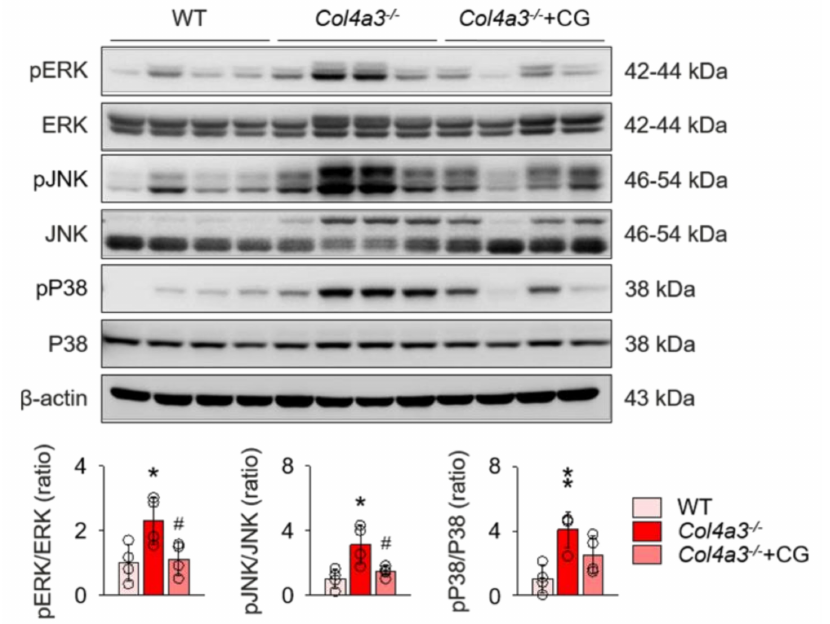
Figure 5. Enhanced phosphorylation of ERK and JNK in Col4a3 − / − mice was suppressed by CG. Comparison of protein expression level of mitogen-activated protein kinases (MAPKs) determined by immunoblotting from the kidney of WT, Col4a3 − / − , and Col4a3 − / − + CG mice ( n = 4 mice / group). β -actin was used as the endogenous control. * p < 0.05, ** p < 0.01 vs. WT mice; # p < 0.05 vs. Col4a3 − / − mice